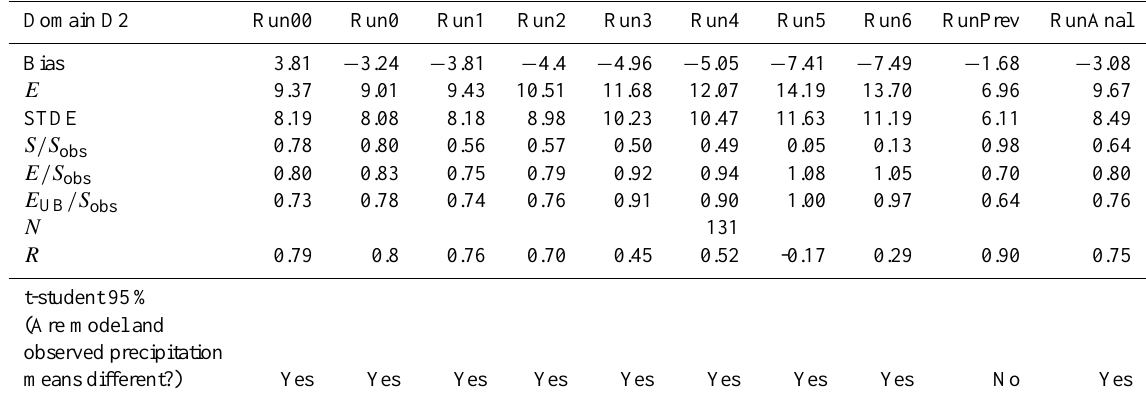
Table 3. Error Analysis over domain D2 ( R is the spatial correlation between simulated and observed precipitation).